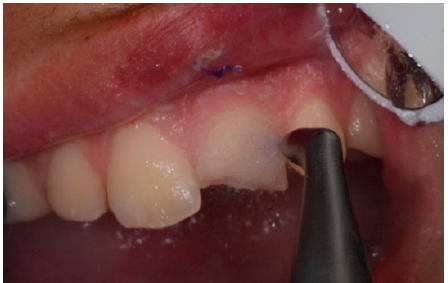
Figure 11. Airpolishing professional oral hygiene with bicarbonate powder.